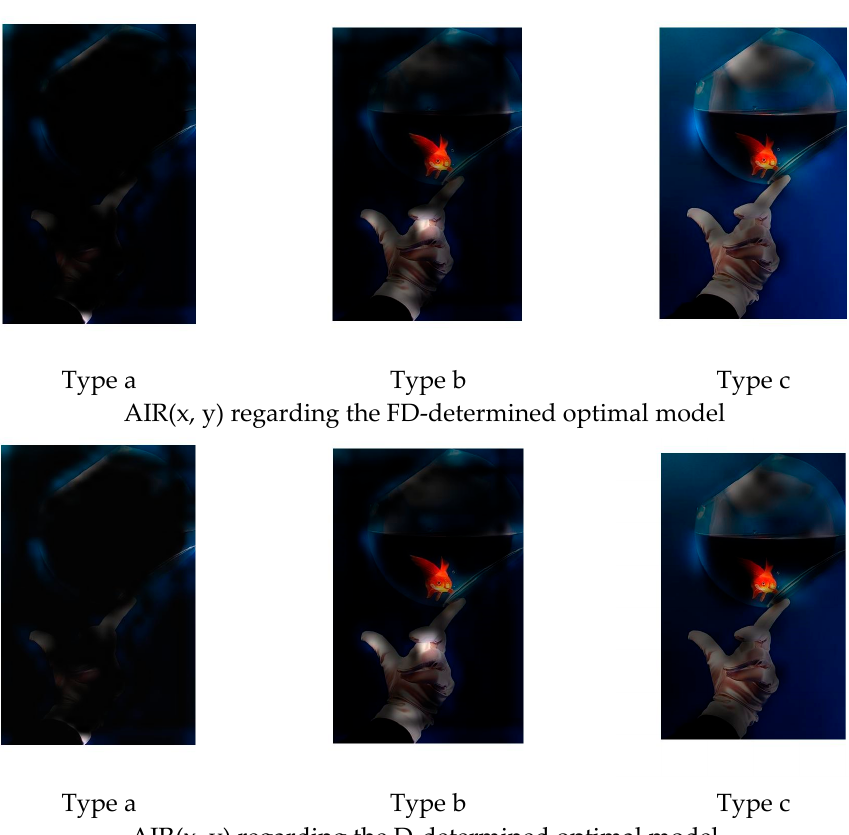
Figure 10. FFP(x, y) of Figure 9.